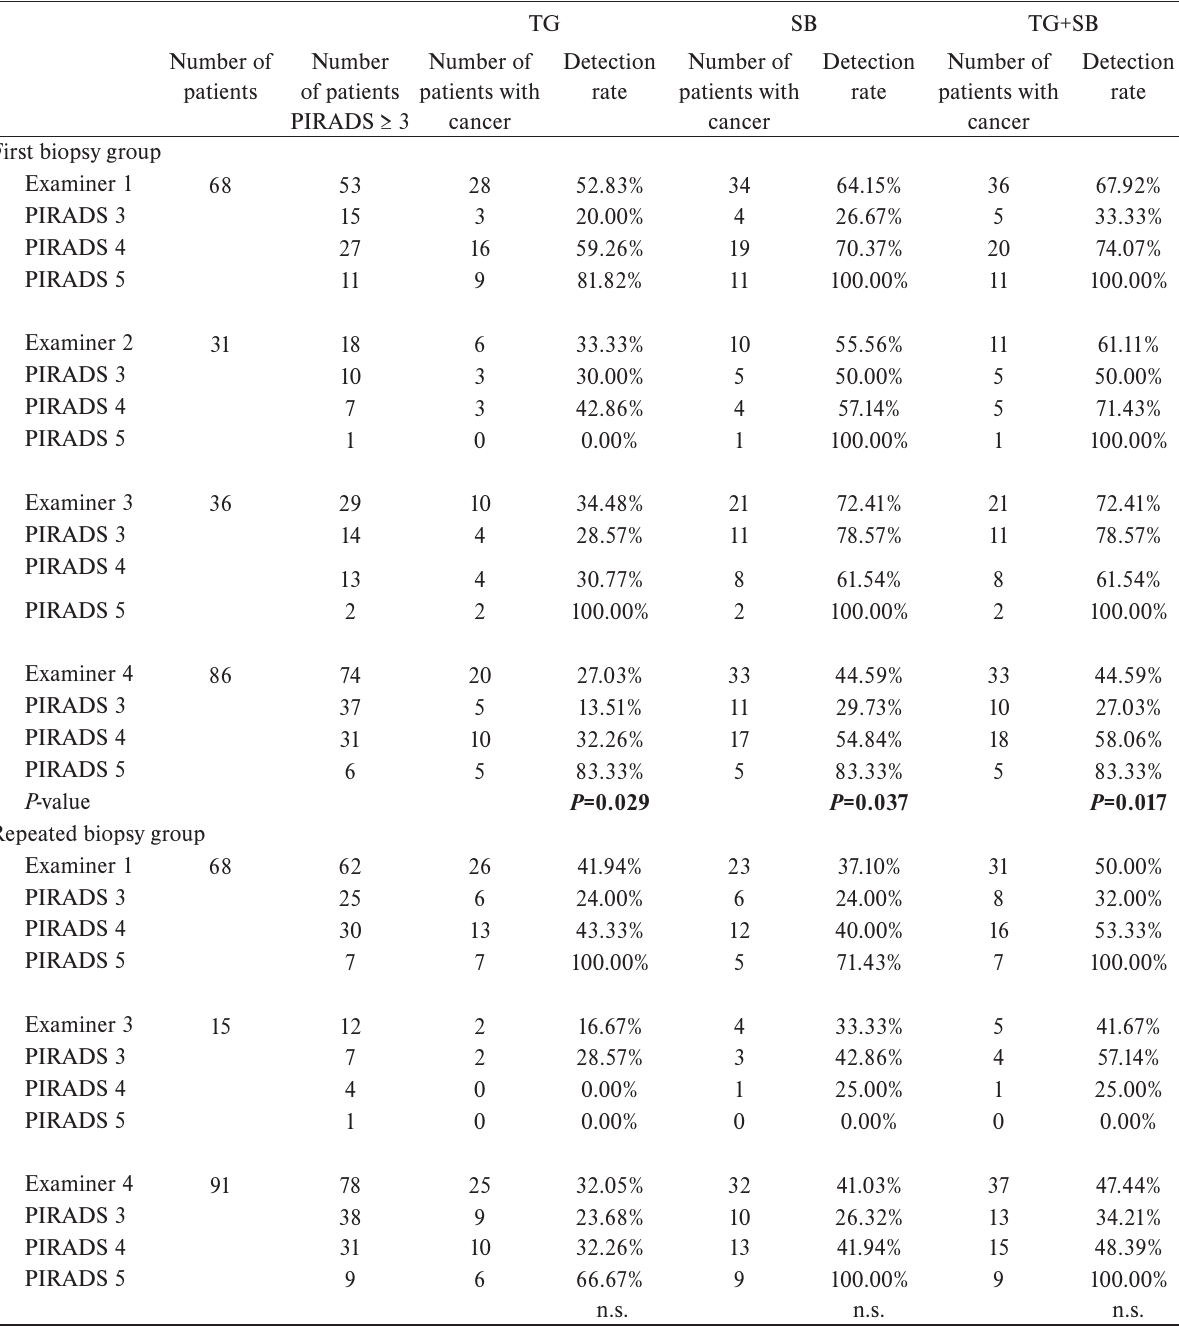
Table 4. Biopsy detection rates stratified according to examiners and PIRADS